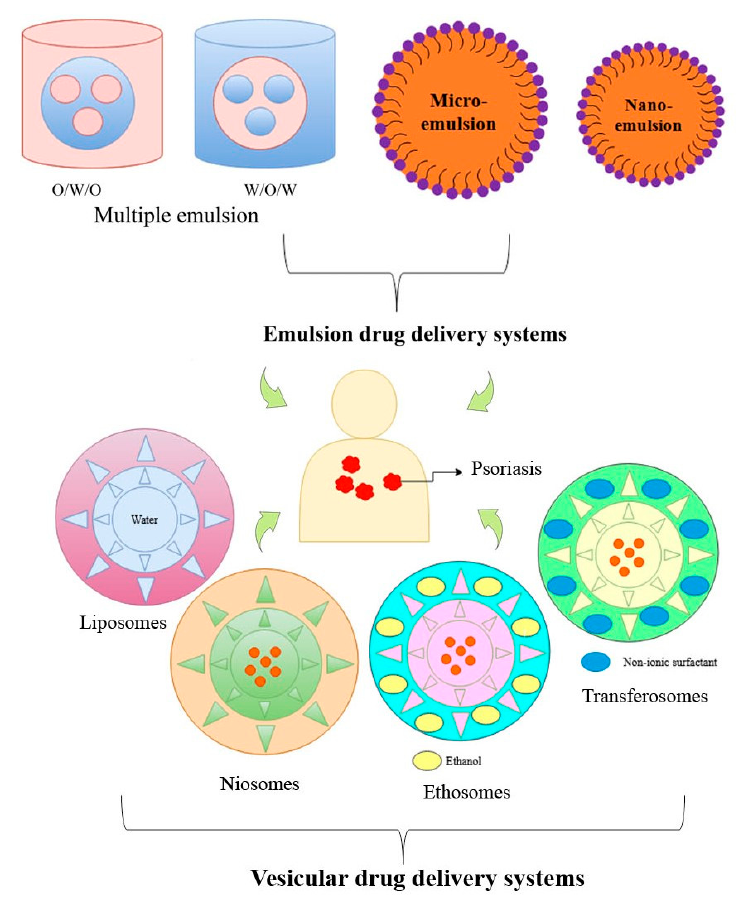
Figure 4. Basic structures of emulsion and vesicular drug delivery systems. Table 6. Recent studies in vesicular drug delivery system for psoriasis treatment.